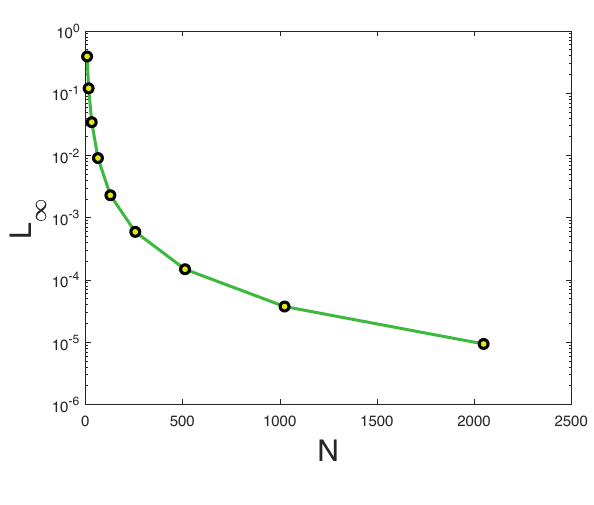
Fig. 1. L ∞ errors for Test Problem 2